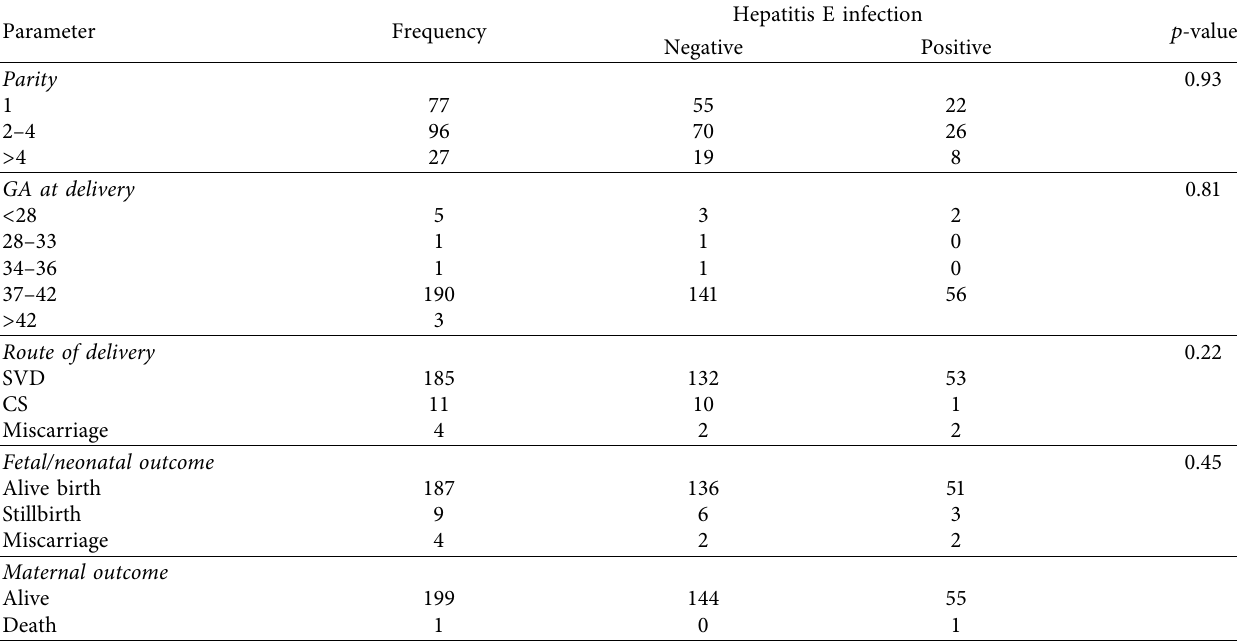
Table 4: Obstetric variable and hepatitis E